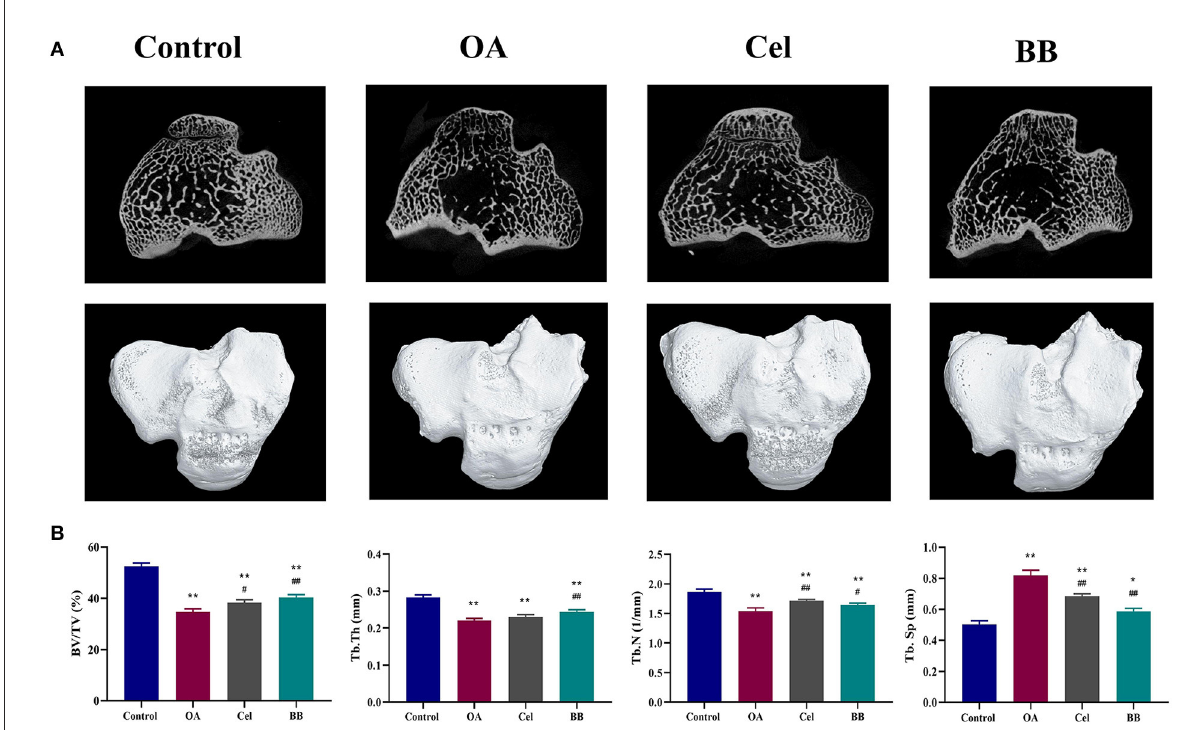
FIGURE3 After 8 weeks of bilobalide treatment, a micro-CT study of the proximal tibia in different groups was performed. (A) Representative Micro-CT 3D images show bone microarchitecture of the proximal tibia in different groups. Scale bar = 5mm. (B) Quantification of BV/TV, Tb.Th, Tb.N, and Tb.Sp in different groups. All data are presented as mean ± SD ( n = 3). * p < 0.05 and ** p < 0.01 vs. control group; # p < 0.05 and ## p < 0.01 vs. OA